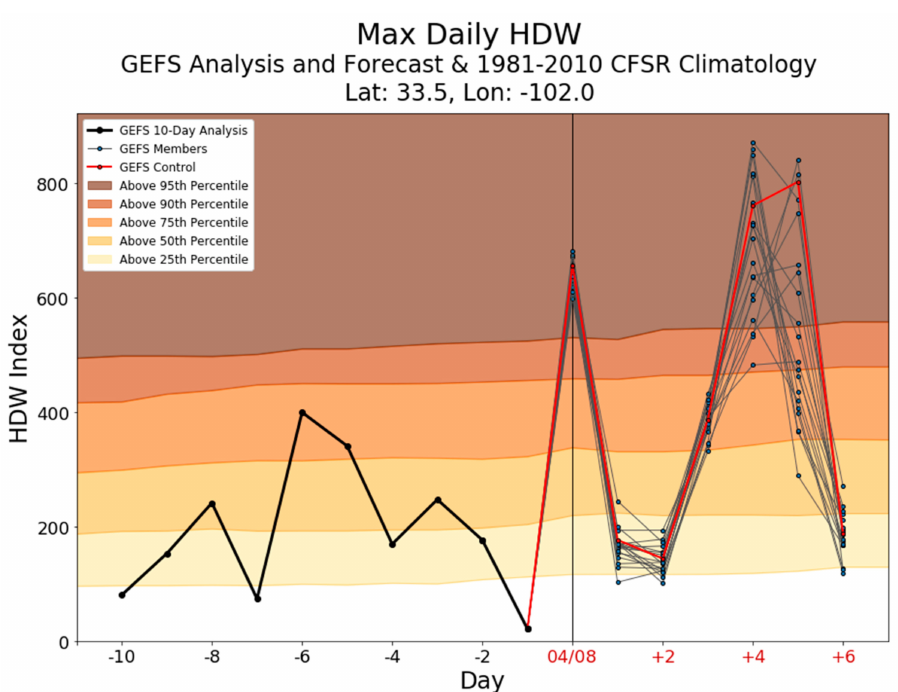
Figure 8. HDW climatological percentiles as in Figure 1, but for a 17-day period surrounding 8 April at grid point 33.5 ◦ N, 102.0 ◦ W. The historical trace (7 April and earlier) represents HDW values calculated from GEFS control-run analyses. The forecast traces represent HDW values calculated from each GEFS ensemble member, with the control run plotted in red and perturbation runs in